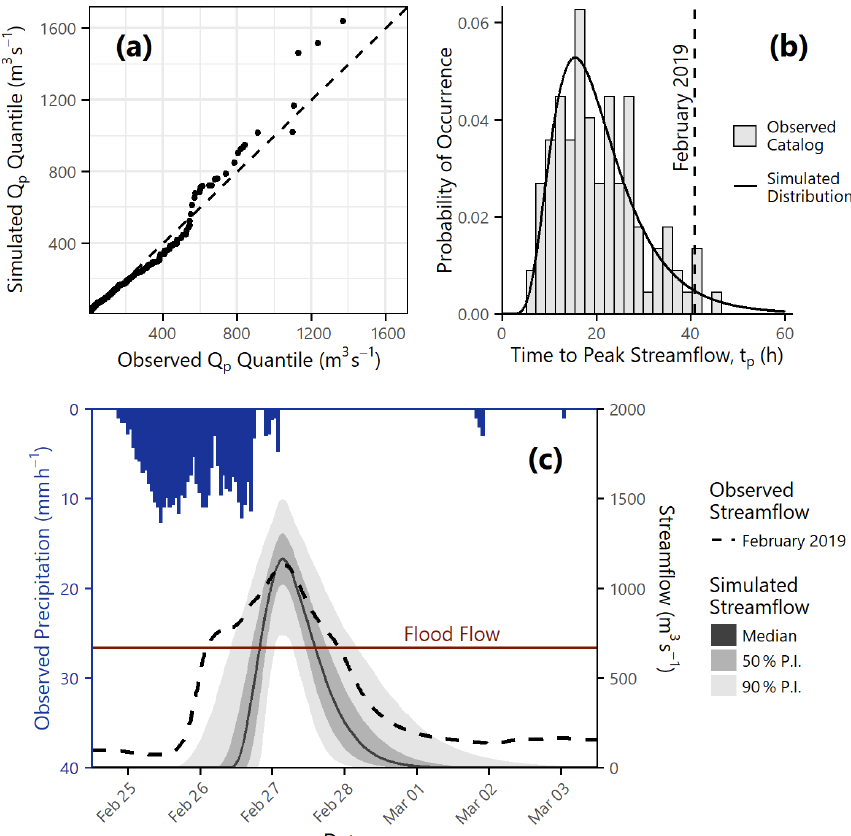
Figure 6. Streamflow component model. All values are calculated with respect to USGS gage 11463500 (study area inlet). (a) Q–Q plot of observed vs. simulated peak streamflow ( Q p ) values for all events in the historic catalog. (b) Observed values from the historic catalog values vs. the fitted lognormal distribution for time to peak streamflow ( t p ). The dashed line indicates the observed time to peak value for the February 2019 event. (c) Distribution of simulated streamflow hydrograph realizations for the February 2019 event. The left axis represents observed hourly precipitation and the right axis represents streamflow. The observed hydrograph timeseries is shown as a dashed black line. The solid line represents the median of the simulated realizations, and the dark and light gray shaded areas represent the 50th and 90th percentile prediction intervals respectively. The horizontal dark red line indicates the National Weather Service flood flow for USGS gage 11463500 (39.7ft or 665m 3 s − 1